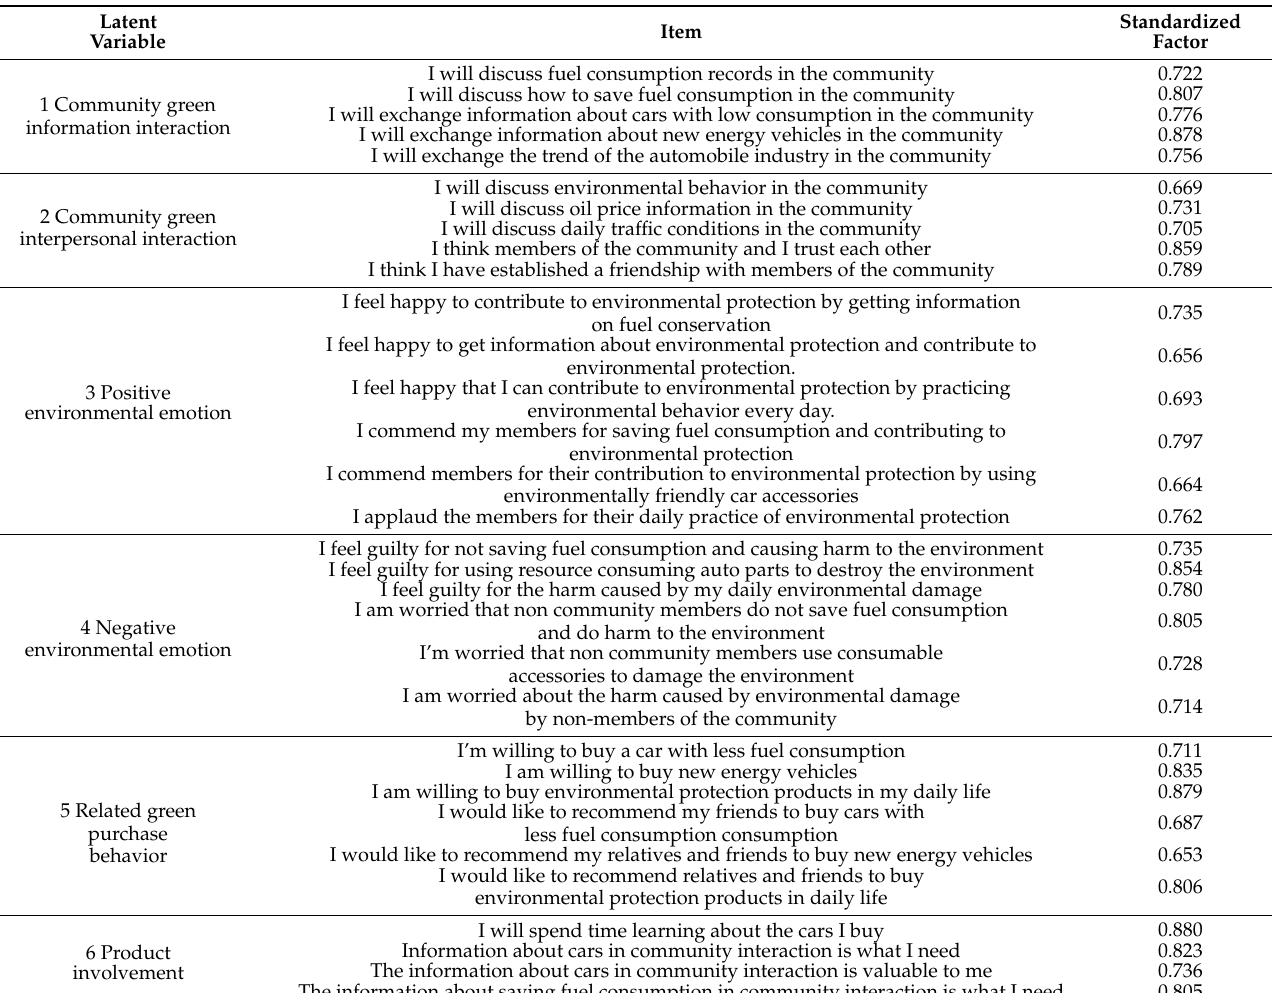
Table 1. Measurement items of the scale and results of confirmatory factor